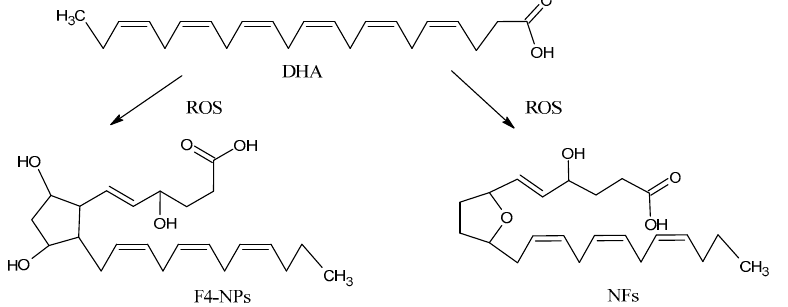
Figure 4. Oxidation products from docosahecsaenoic acid (DHA): neurofurans (NFs) and neuroprostanes (NPs).